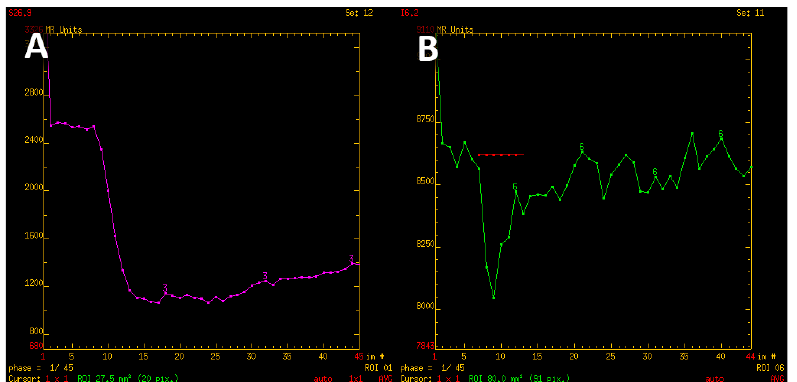
Figure 8. T2* signal intensity curve characteristic for meningioma, with minimal return to the baseline ( A ). Contrary, signal intensity curve of adamantinomatous craniopharyngioma shows rapid return and even exceeds the baseline values ( B ).